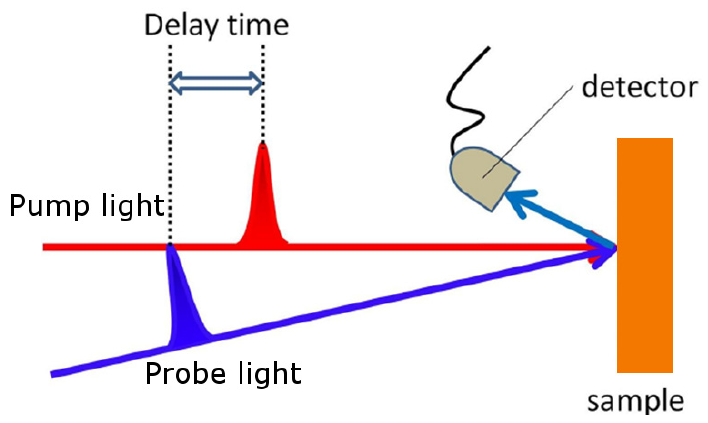
Figure 1. Typical setup for time-resolved reflectivity